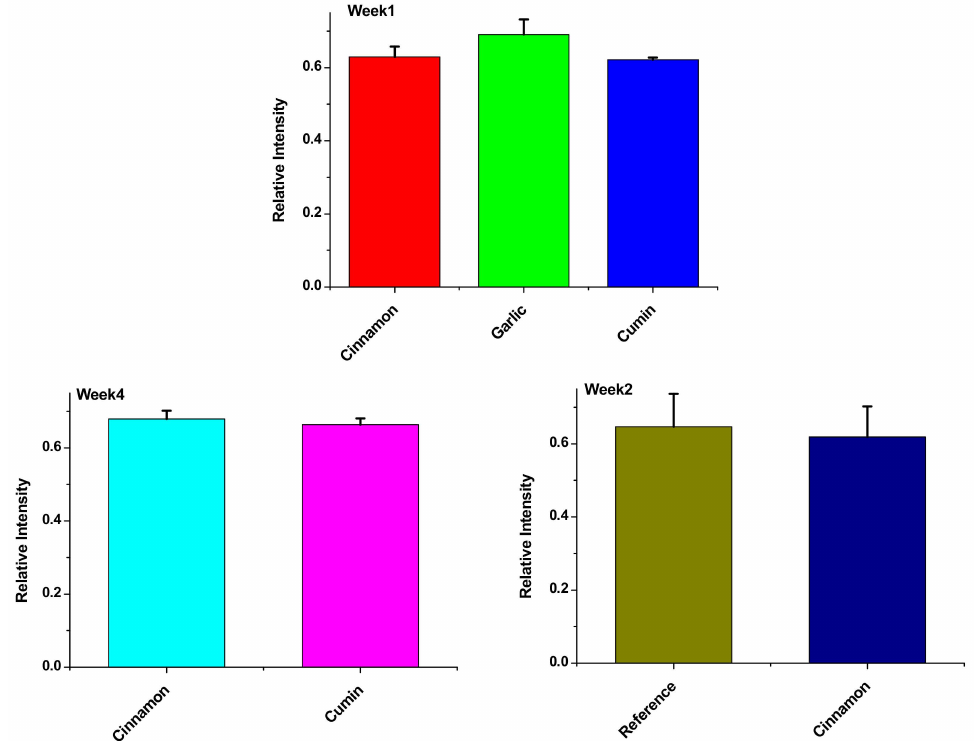
Figure 3. Amide-I (C = O) (1600 − 1690 cm − 1 ) for antioxidant treated and non-treated minced fillets of Ehrenberg’s Snapper at − 25.0 ◦ C at di ff erent timing from 1week to 4 weeks. Data are expressed as the mean ± SD, n =